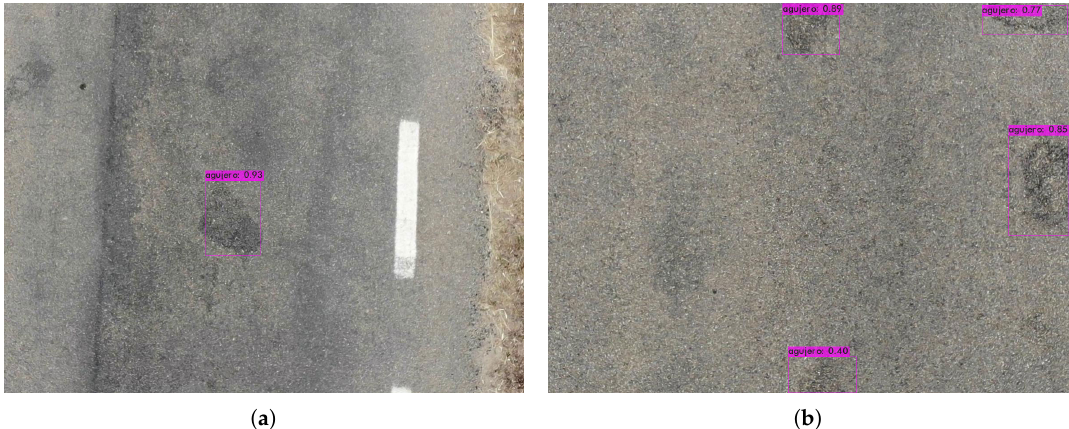
Figure 9. Detection results with zoom. ( a ) Single detection. ( b ) Multiple detection.